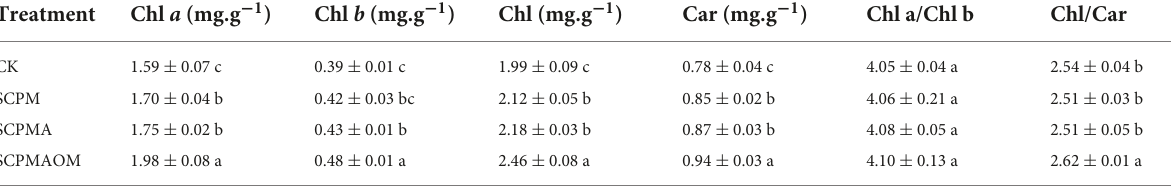
TABLE 1 Content of chlorophyll and carotenoid in C. tangshen leaves in different treatments.